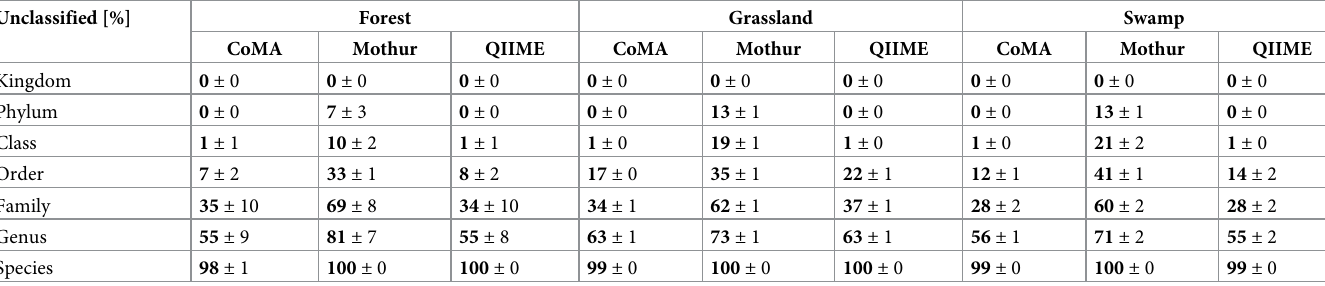
Table 5. Unclassified reads for each taxonomic level in three different soils: Forest, grassland and